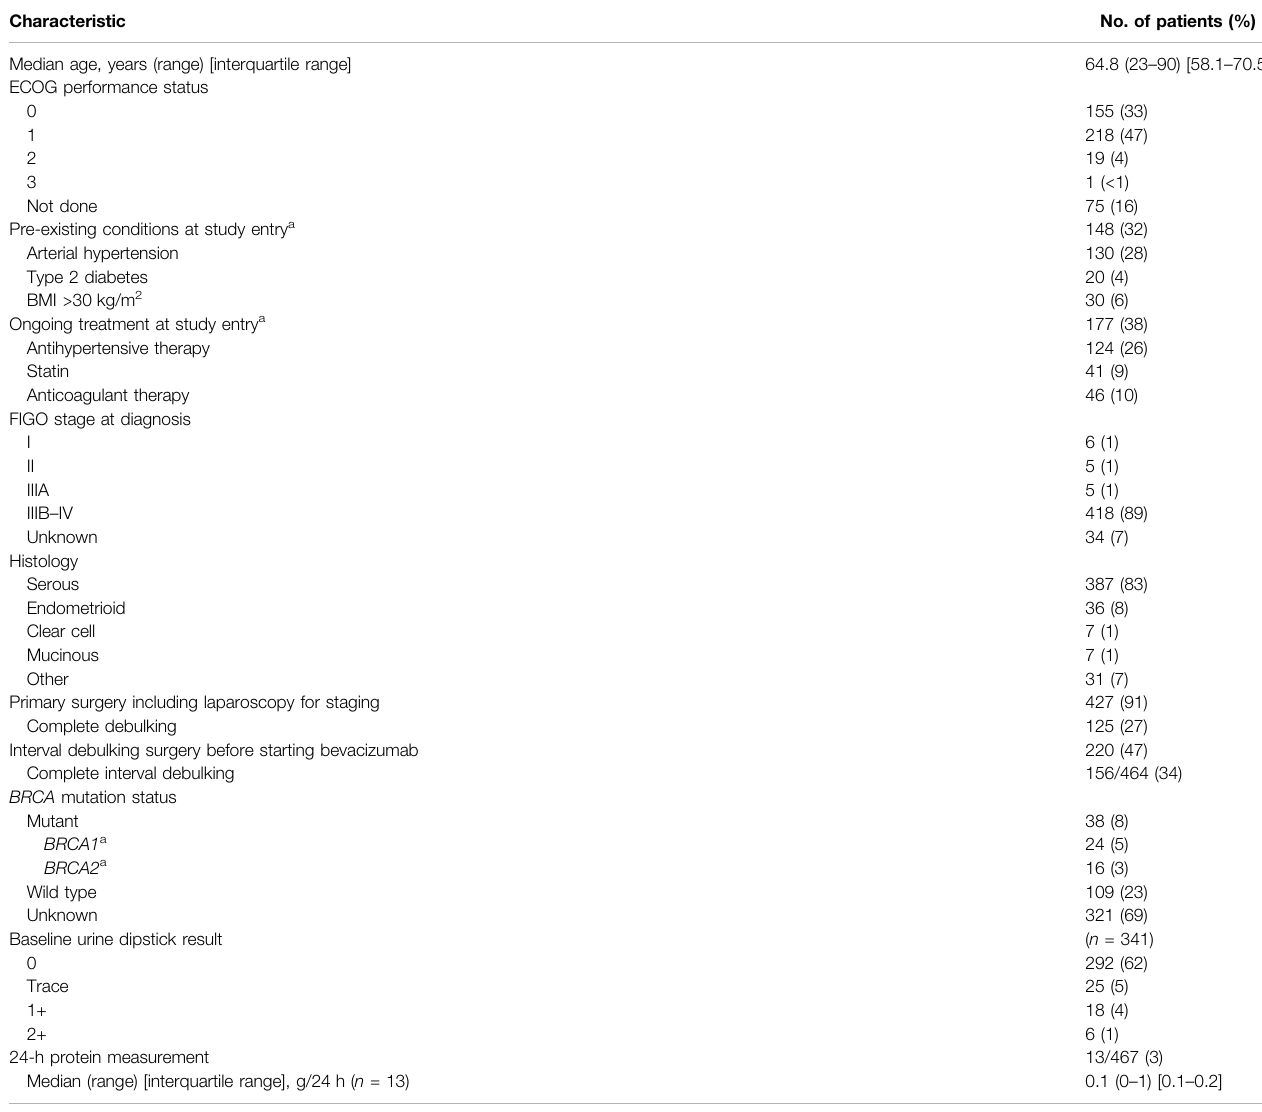
TABLE 1 | Baseline characteristics of analyzed patients ( N (cid:1) 468).